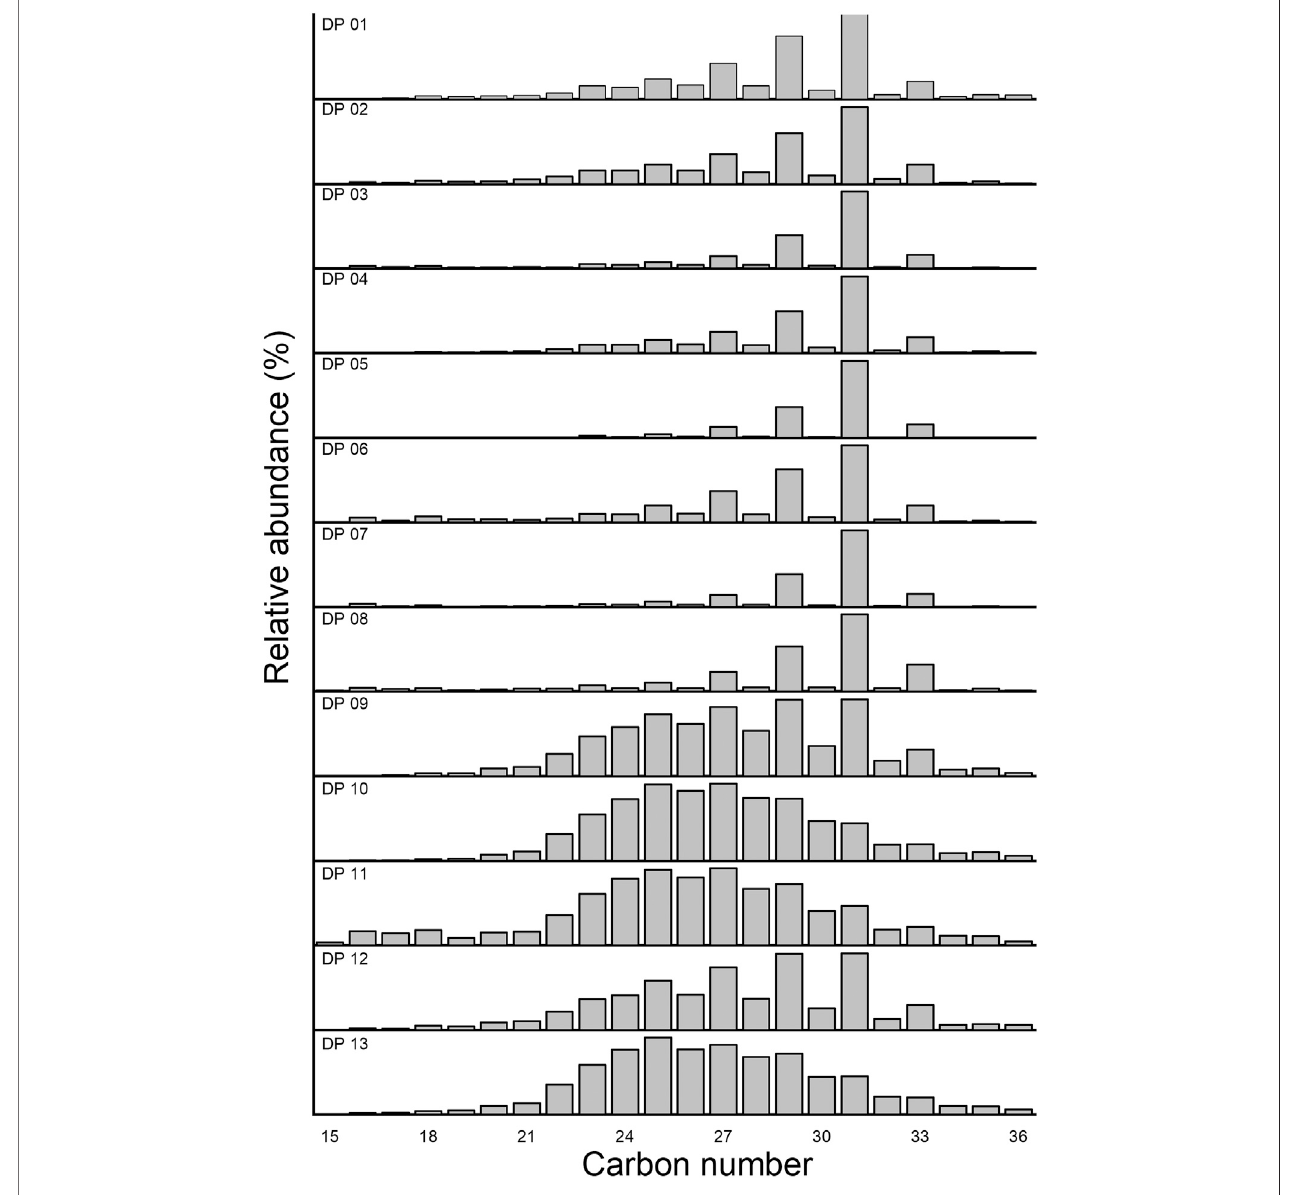
FIGURE 7 | Distributions of n-alkanes in 13 samples from the salt lake sediments.